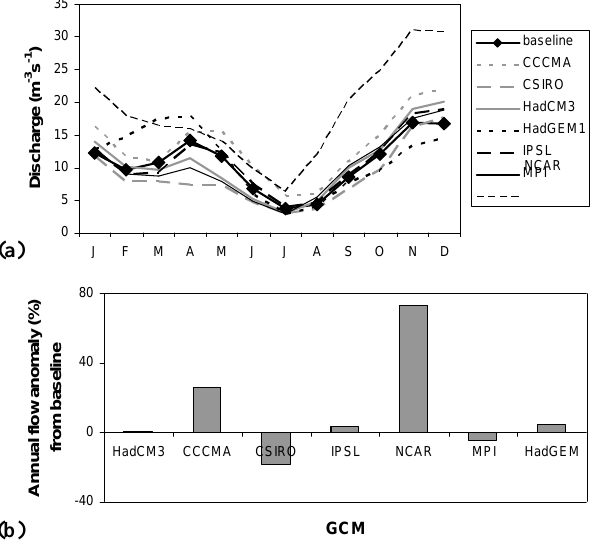
Figure 9 Fig. 9. (a) Temperature and (b) precipitation only climate change signals in River Mitano discharge for 2 ◦ C prescribed warming sce- narios across 7